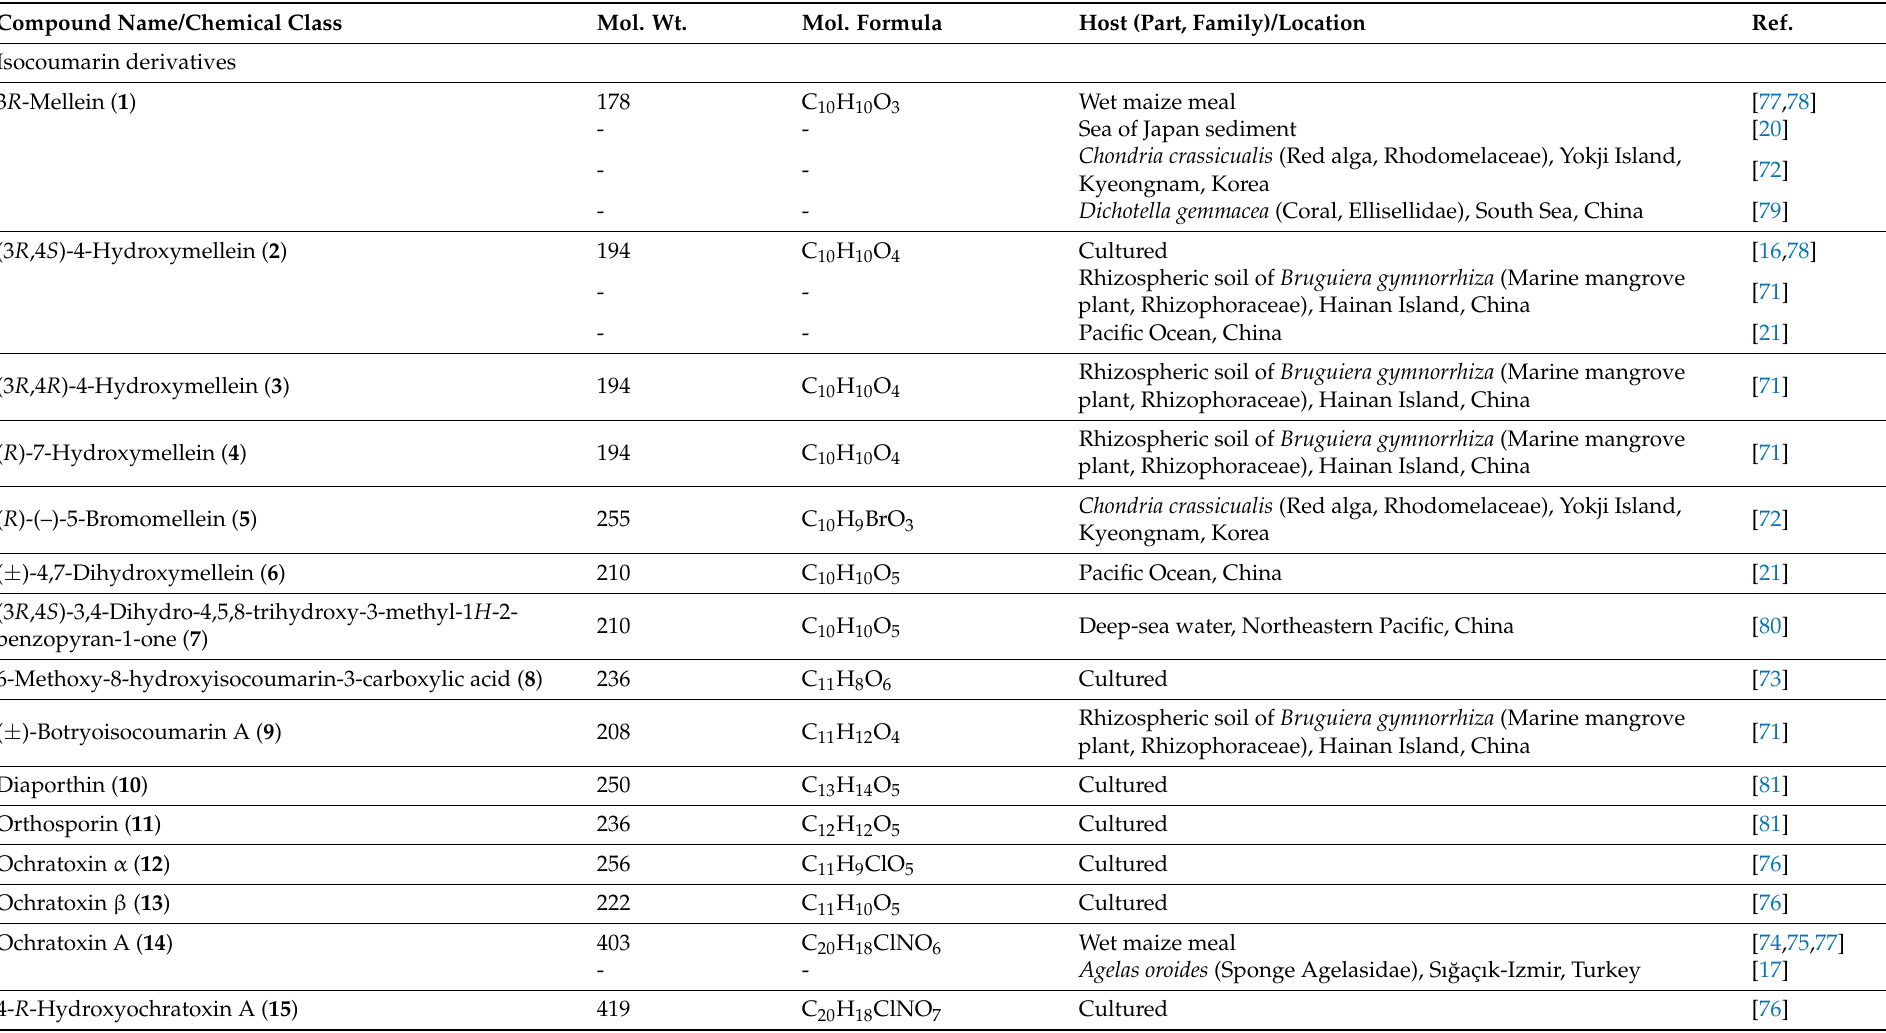
Table 1. Secondary metabolites reported from Aspergillus ochraceus (chemical class, molecular weight and formulae, fungal source, host, and